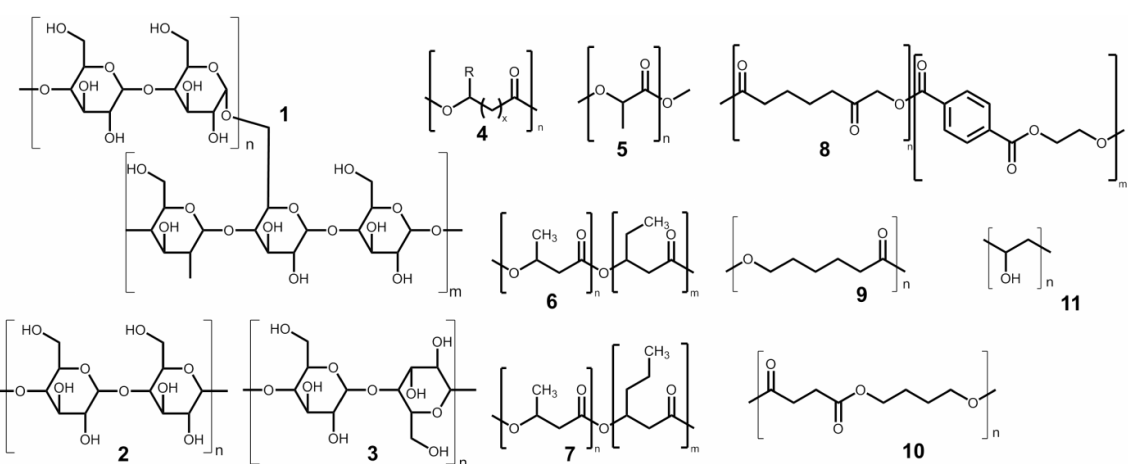
Figure 5. Established biodegradable polymers potentially usable as carrier substrates. Starch originating from potatoes or corn consist of the branched amylopectin ( 1 ) and linear amylose ( 2 ). Cellulose ( 3 ) is structurally similar, but differs from the bonding type between the glucose monomers. Polyhydroxy alkanoates (PHA) ( 4 ) and polylactic acid (PLA) ( 5 ) may derive from various sugars, fatty acids or starch. Other typical representatives are polyhydroxybutyrate-co-valerate (PHBV) ( 6 ) and polyhydroxybutyrate-co-hexanoate (PHBH) ( 7 ). Polybutylene adipate-co-terephthalate (PBAT) ( 8 ) is a polymer with aromatic fragments. Polyesters are represented by polycaprolactone (PCL) ( 9 ), and polybutylene succinate (PBS) ( 10 ). Polyvinyl alcohol (PVA) ( 11 ) has a rather simple structure compared to the aforementioned